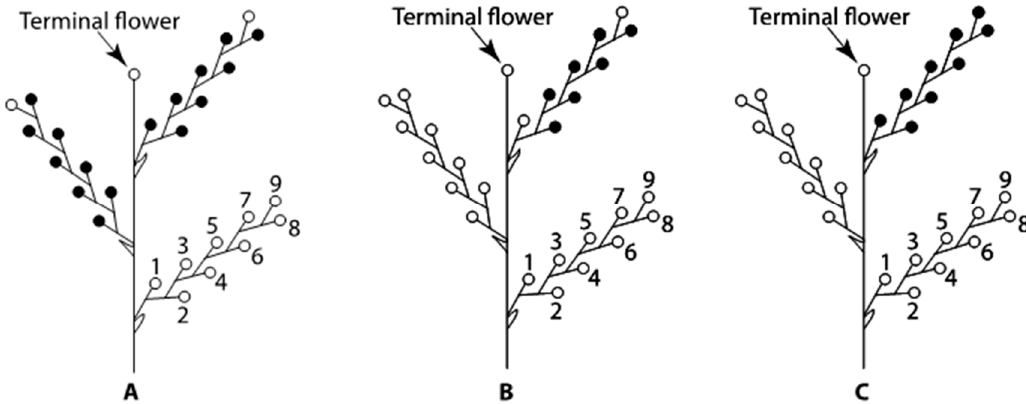
Figure 12. Scheme of Nicotiana tabacum cymes indicating the flowers and cymes collected for corolla growth analysis ( A ), scanning electron microscopy and histological analyses ( B ), and supplementary materials for histological analysis ( C ). Flower positions 1 through 9 are marked on one of the three cymes. ( A ) Corolla growth was measured on the first eight flowers (closed circles) to open on two cymes from each of the six plants in Group 1 tobacco plants. ( B ) Scanning electron microscopy and histological analyses were conducted on the seven flowers or flower buds (closed circles at positions 2 to 8) on one cyme from each of the six plants in Group 2 tobacco plants. ( C ) One cyme from each of the six plants in Group 3 tobacco plants was collected as supplementary materials for histological analysis. The corolla lengths of the first flowers in these six cymes were the same as those of the six cymes in Group 2 plants.